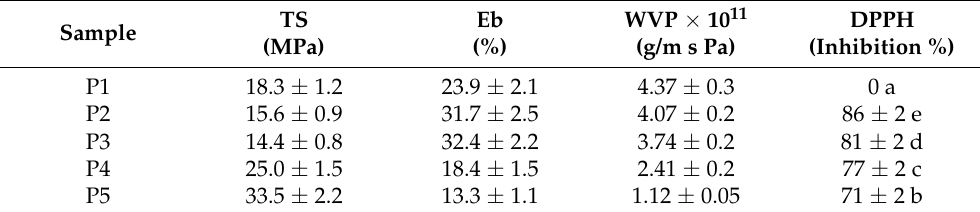
Table 1. Mechanical parameters, WVP, and antioxidant activity of pectin-based biocomposite films.